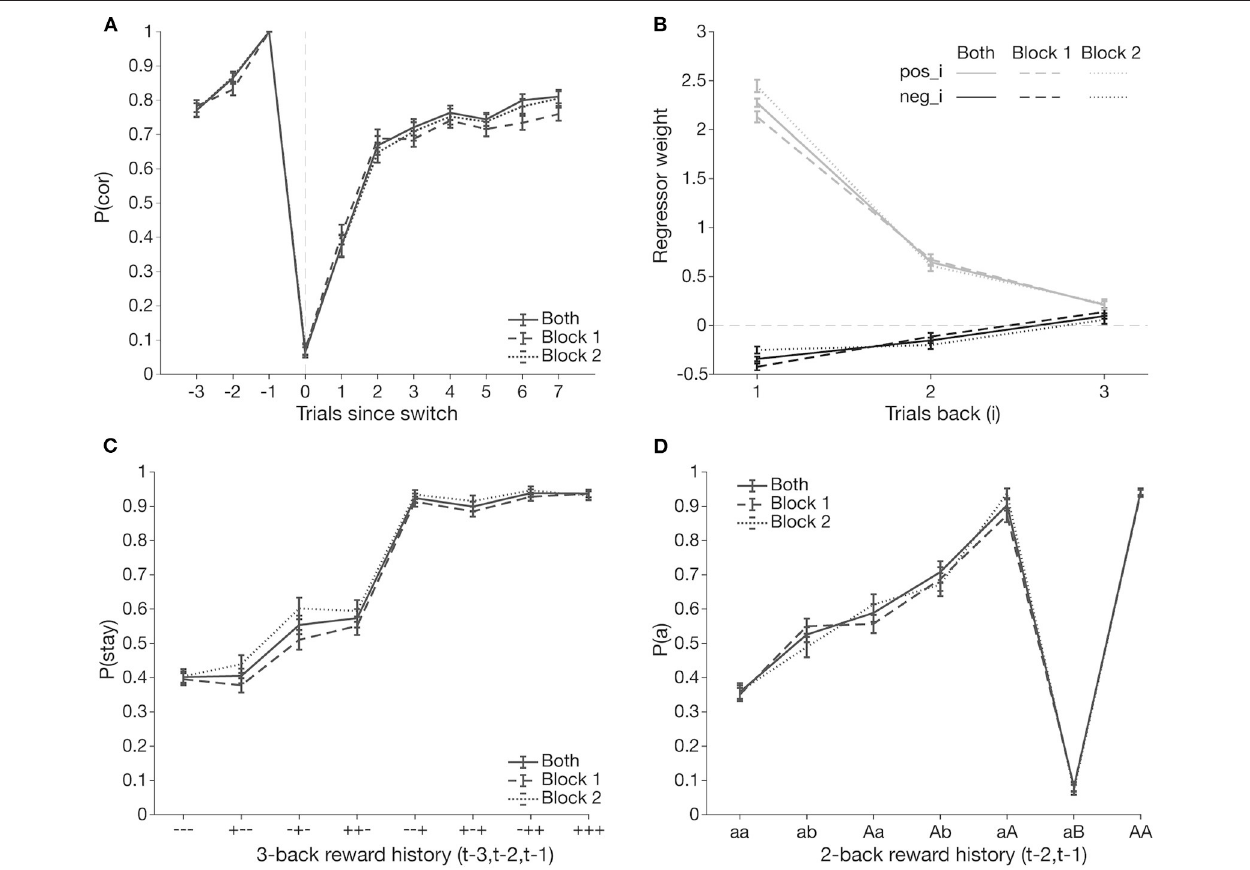
FIGURE 2 | Group level switching behavior. Joint block behavior (solid line) is comparable to behavior from only block 1 (dashed line) and only block 2 (dotted line). Data points are averaged over all participants, bars represent standard error of the mean. (A) Probability of selecting the correct box [ p ( cor )] surrounding a switch trial ( t = 0). (B) Comparison of regressor weights from GLME predicting an action based on reward outcomes from up to three trials past ( t − 3). Past positive outcomes ( pos_i , light) are more likely to induce selecting the same action; a negative outcome ( neg_i , dark) at t − 1 has the greatest effect to induce a switch. (C) Probability of repeating the previous trial’s choice [ p ( stay|- - - )] as a function of three trial-back reward histories [ t − 3, t − 2, and t − 1]. (D) Probability of selecting an action a at trial t given that was selected two trials ago ( t − 2), across all possible action and reward outcomes on t − 1 [ t − 2, t − 1]. “b” indicates selection of the other action; lower/upper case indicates whether the action was